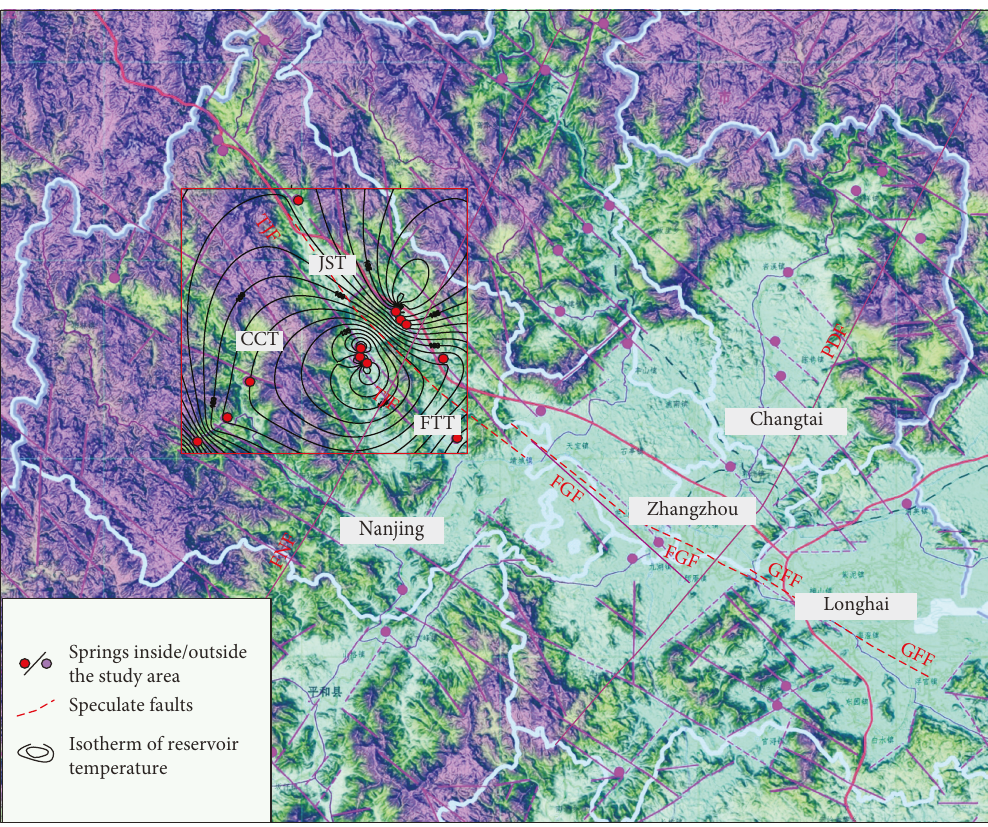
Figure 8: Map of the structural interpretation of remote sensing. The red square refers to the area of Figure 7. For abbreviations, see Figures 1 and 2.